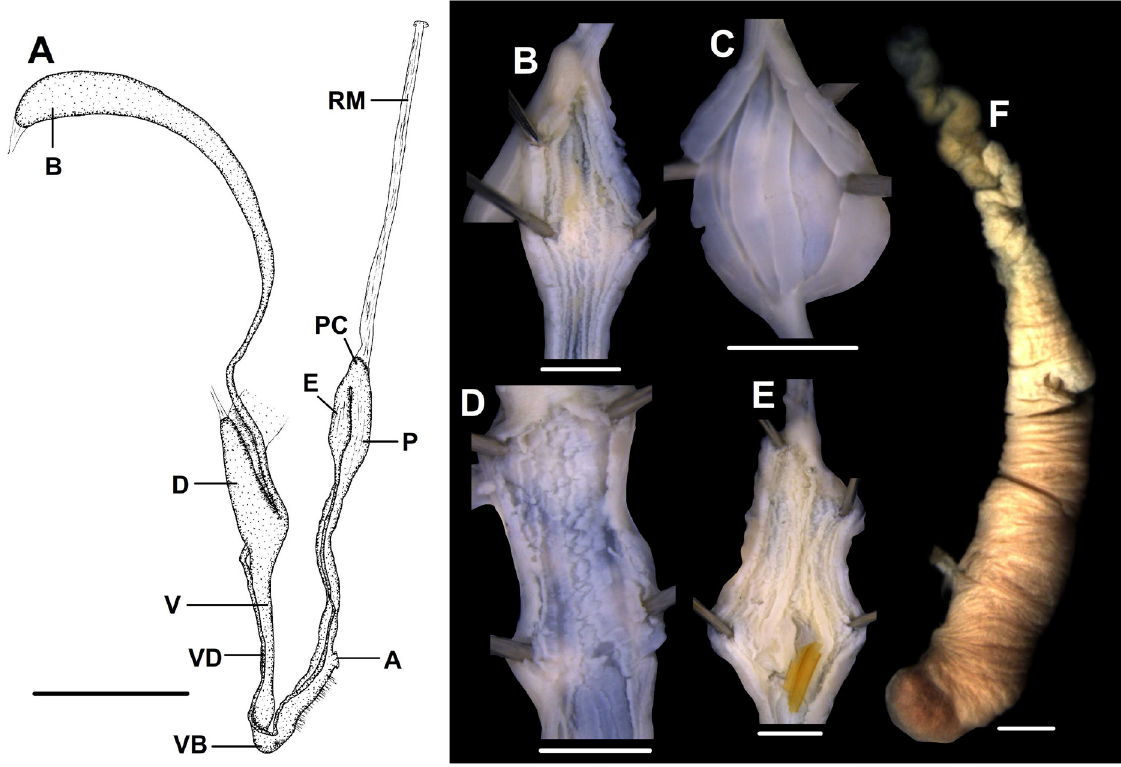
Fig. 37. Genitalia of Plectopylis bensoni Gude, 1914 (NHMUK 20170152). A . Distal genitalia. B–E . Inner structure of genital organs (B = penis, C = epiphallus, D = vagina, E = diverticulum). F . Spermatophore found in the bursa copulatrix. A and F show one specimen, whereas B–E show another specimen. Scales bars: A = 5 mm; B–F = 1 mm. For abbreviations see Fig. 2. All photos: B.